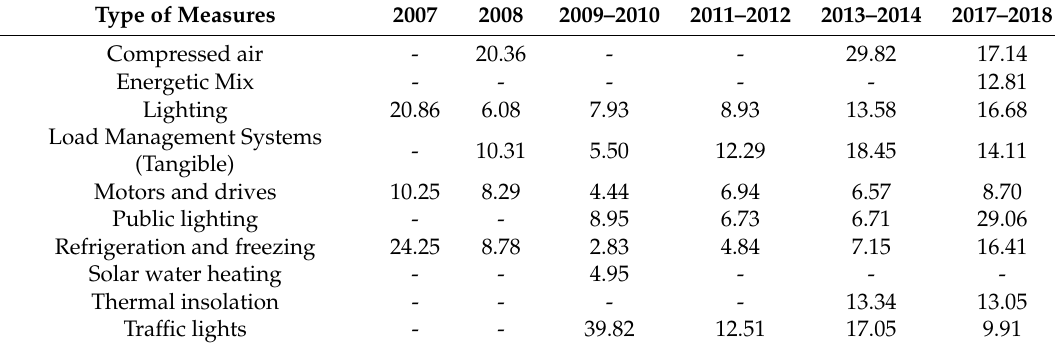
Table 4. Average PA costs of each avoided MWh of the selected measures in each PPEC edition [19–26].